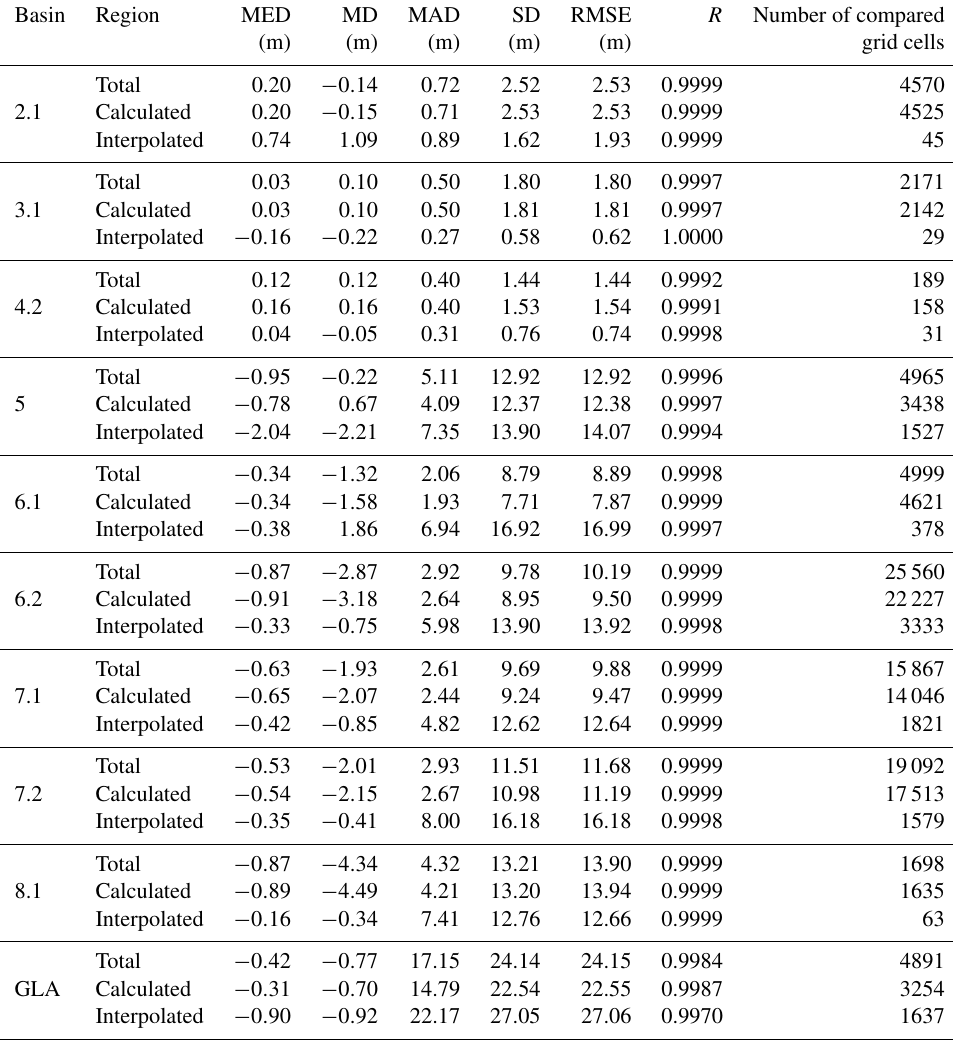
Table 4. Elevation differences between the ICESat-2 DEM and IceBridge data in different basins, calculated for all of Greenland and